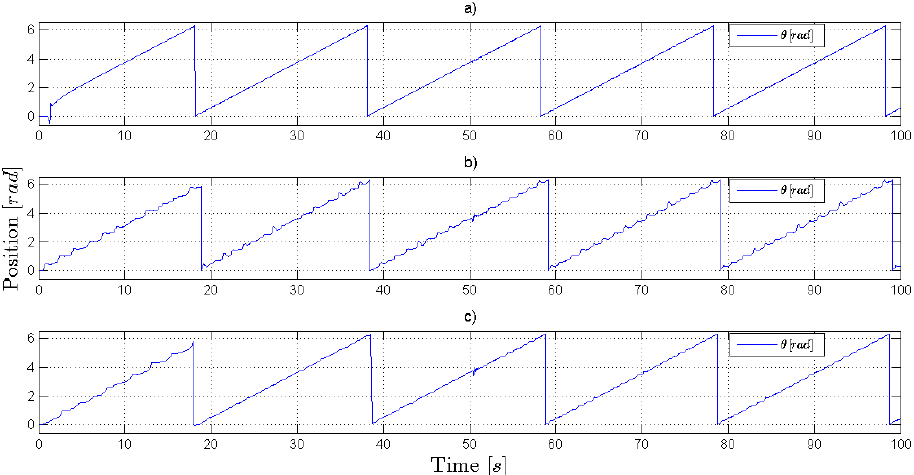
Figure 3. Angular positions when the velocity is controlled to 0.3142 rad/s. ( a ) FSLC as the velocity controller; ( b ) PI as the velocity controller; and ( c ) ANN as the velocity controller.